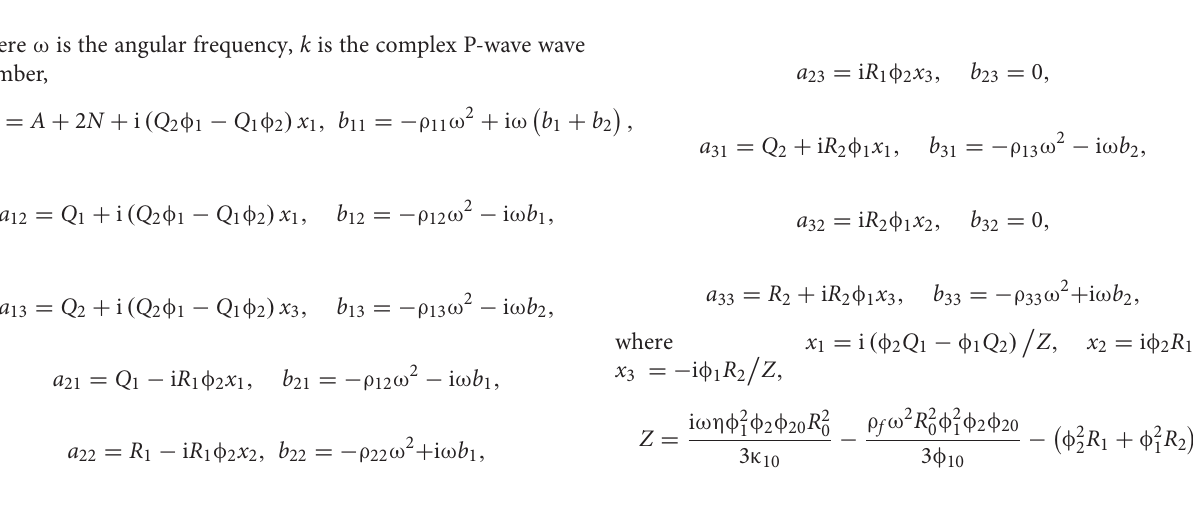
where ω is the angular frequency, k is the complex P-wave